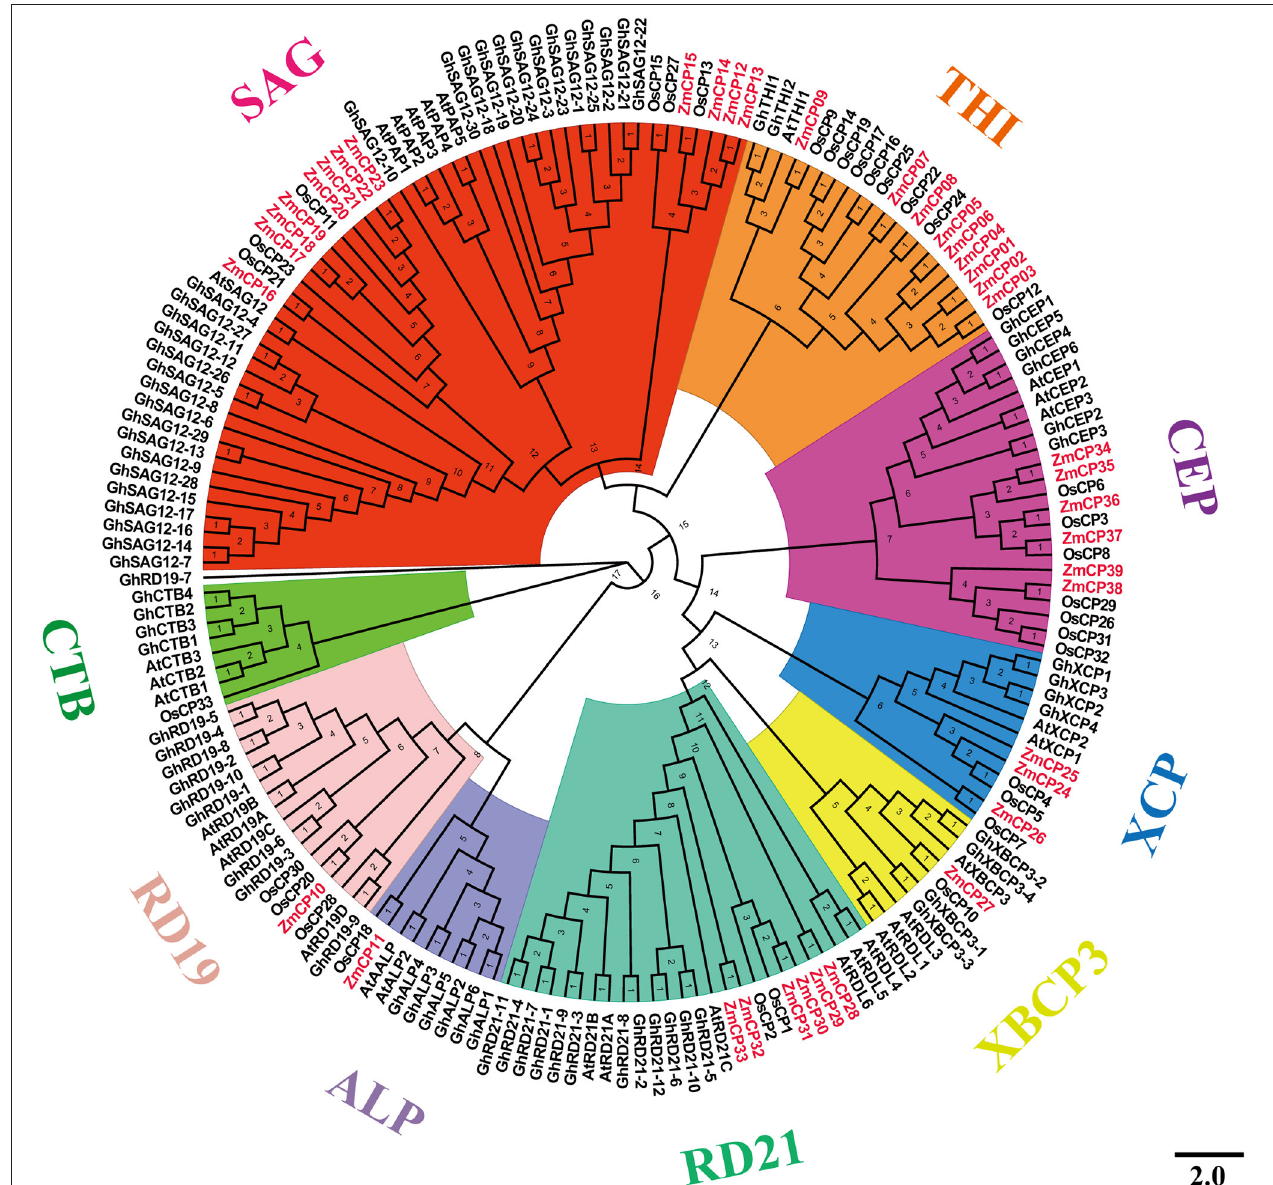
FIGURE 1 | Evolutionary relations among 181 cysteine protease (CP) genes among the four plant species